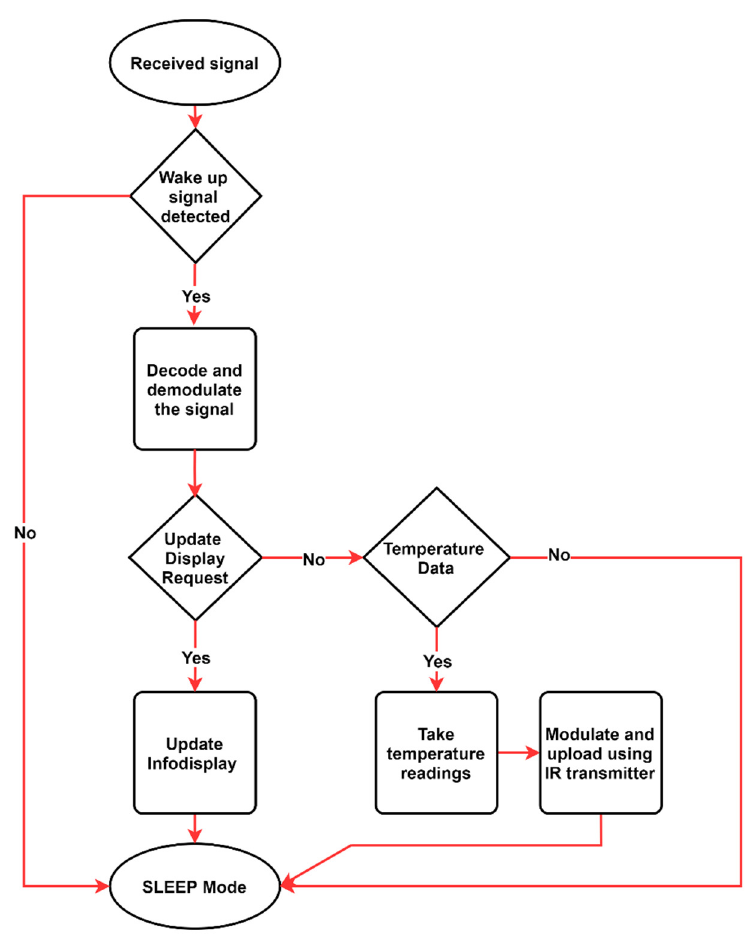
Figure 8. Designed algorithm for the LIoT smart label.